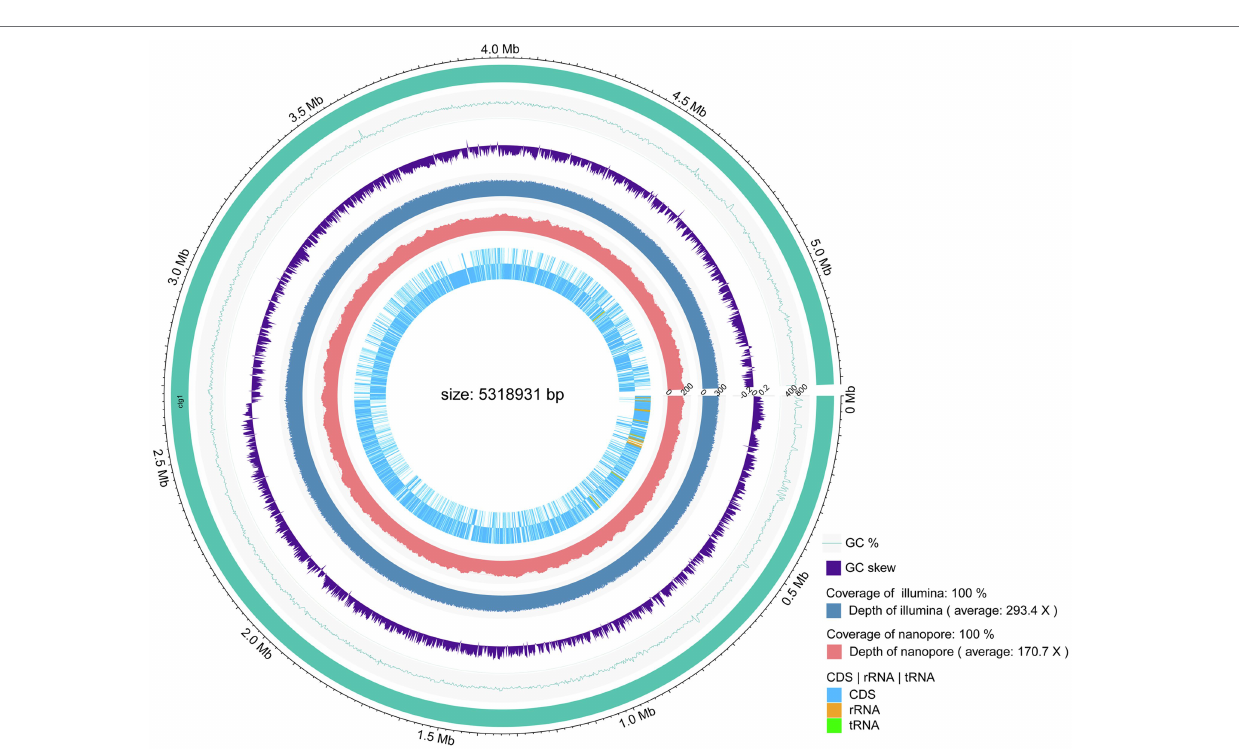
FIGURE 4 | Circular representation of the PGP15 chromosome. The peripheral circle represents the genome with sizes marked in Mb. The second and third circles show the GC content and GC skew, respectively. The fourth and fifth circles indicate the coverage levels of Illumina and Nanopore sequencing, respectively. The inner two circles represent the distribution of predicted CDSs, tRNAs, and rRNAs.